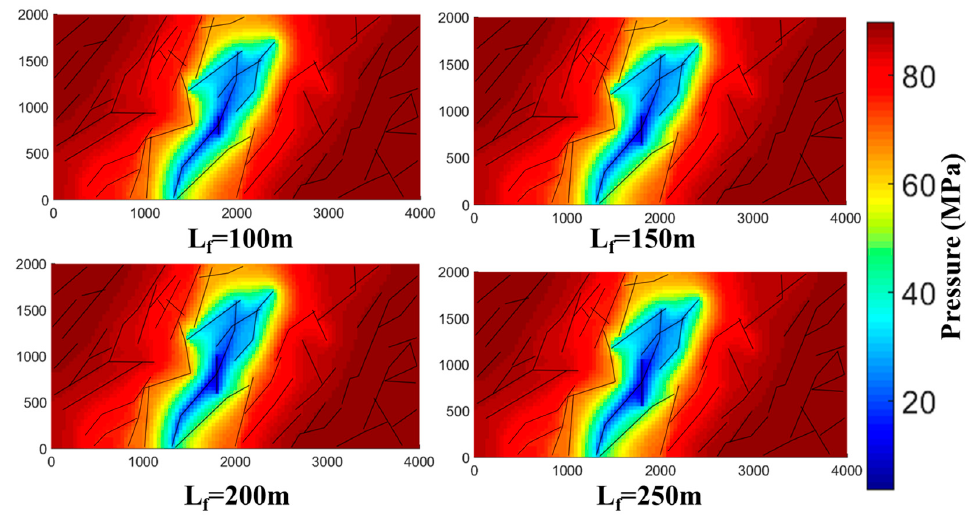
Figure 11. Schematic diagrams of pressure- drop-vulnerability distribution for different half-fracture-length models. The comparison diagram of cumulative gas production under different half-fracture